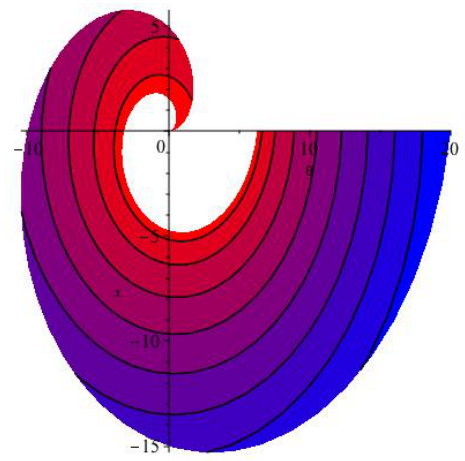
Figure 2. Contour plot obtained using Maple 2019 software, taking contours at various z values up to z =